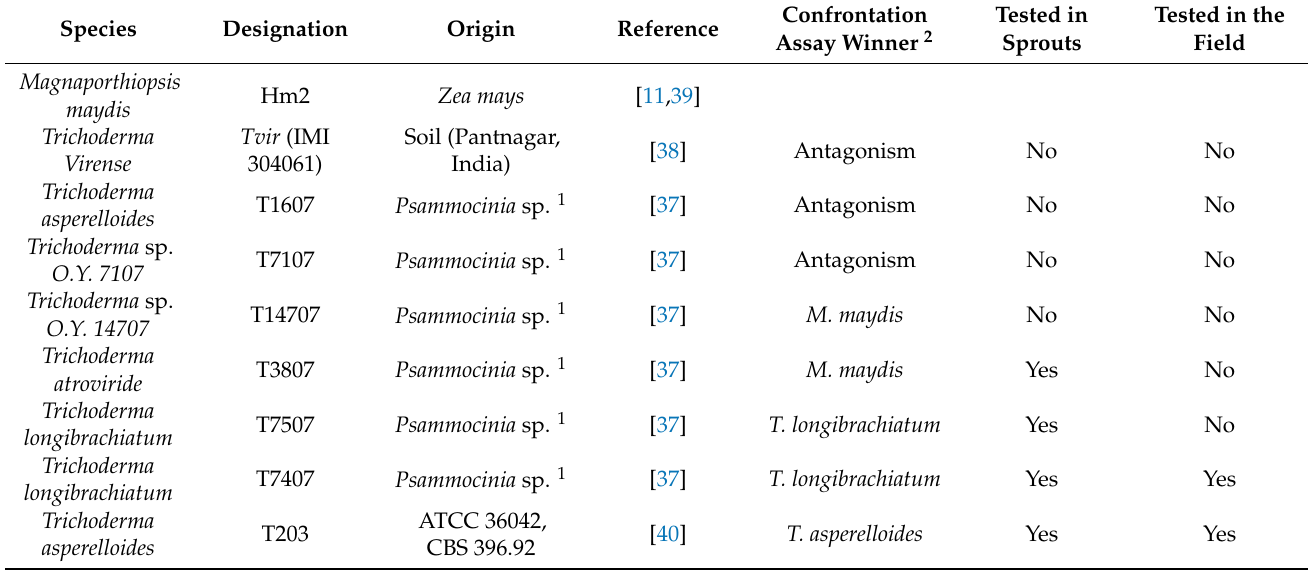
Table 1. Fungi used in this research and plate confrontation assay